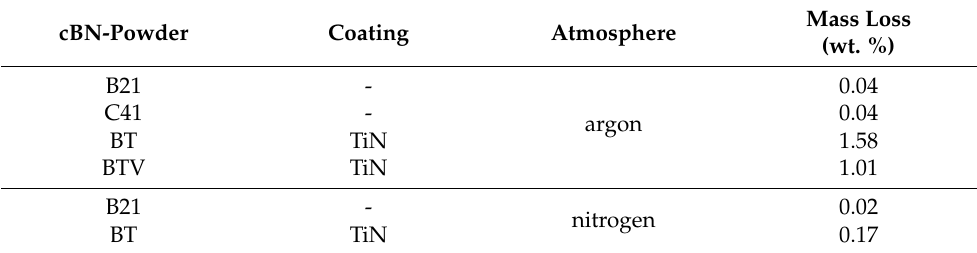
Mass Loss (wt. %) argon